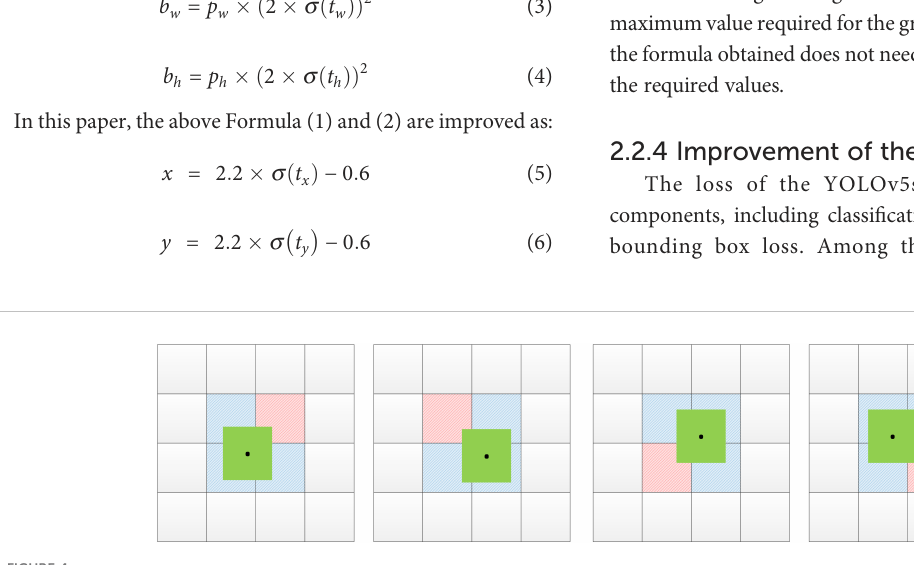
FIGURE 4 The prediction grid corresponding to the different positions of the real